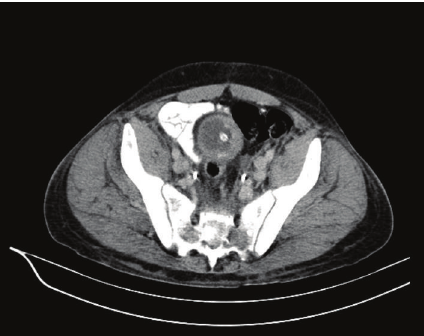
Figure 4: Left eye hyperemia and exophthalmos due to sphenoidal bone metastasis compressing the eye